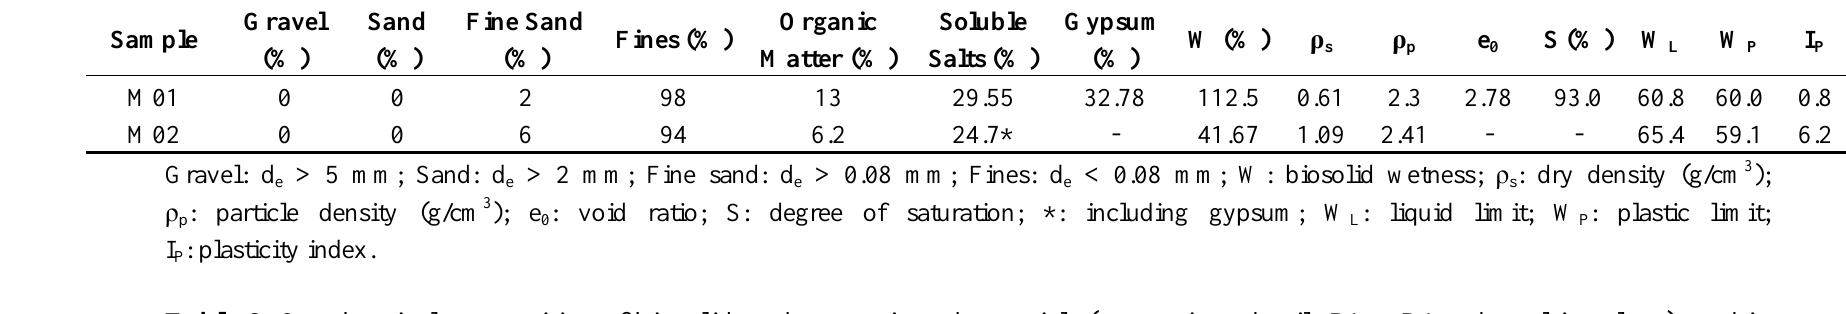
Table 1. Main characteristics of biosolid (sewage sludge) used in the experiments.